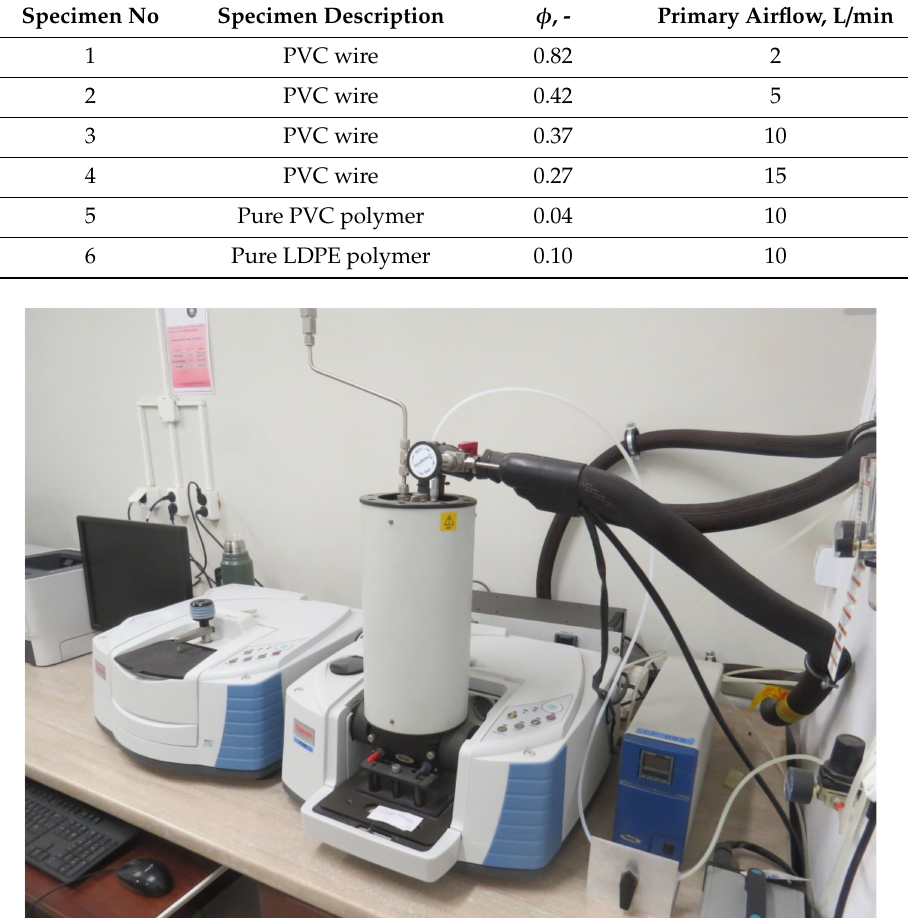
Table 1. Test conditions and specimens’ description.